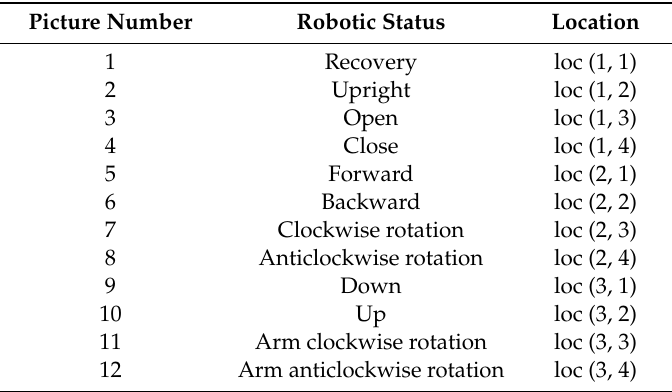
Table 2. The content of stimulation image.